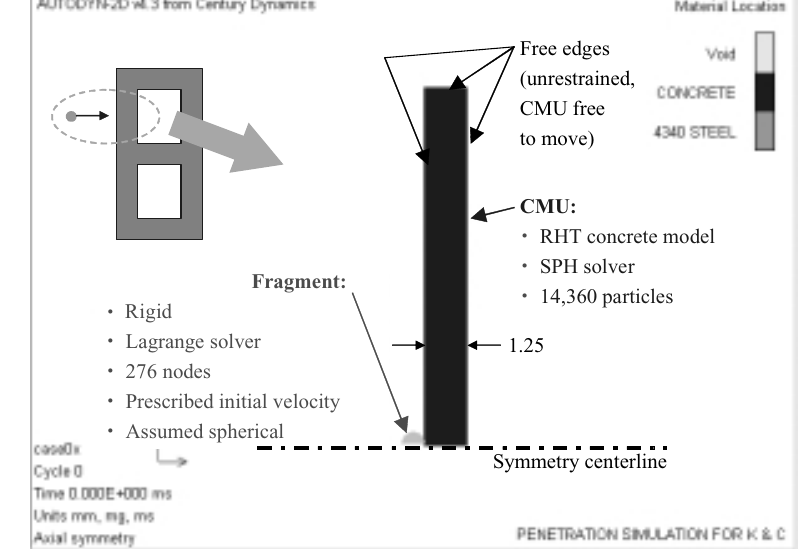
Fig. 2. Overview of model used to calculate fragment penetration of CMU.